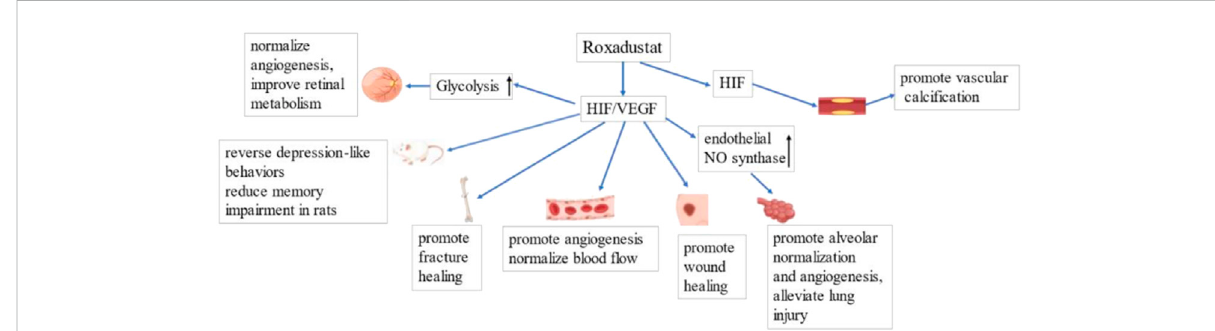
FIGURE 5 Roxadustat promotes angiogenesis by upregulating HIF/VEGF. Left to Right: Roxadustat promotes glycolysis, thereby improving retinal metabolism and normalizing blood fl ow. Roxadustat reverses depression-like behavior and reduces memory impairment in rats. Roxadustat promotes wound and fracture healing by promoting angiogenesis and normalization of blood fl ow. Roxadustat upregulates the expression of endothelial NO synthase, promotes alveolar normalization and angiogenesis, and thereby attenuates lung injury. Roxadustat may also lead to vascular calci fi cation, increasing the risk of cardiovascular